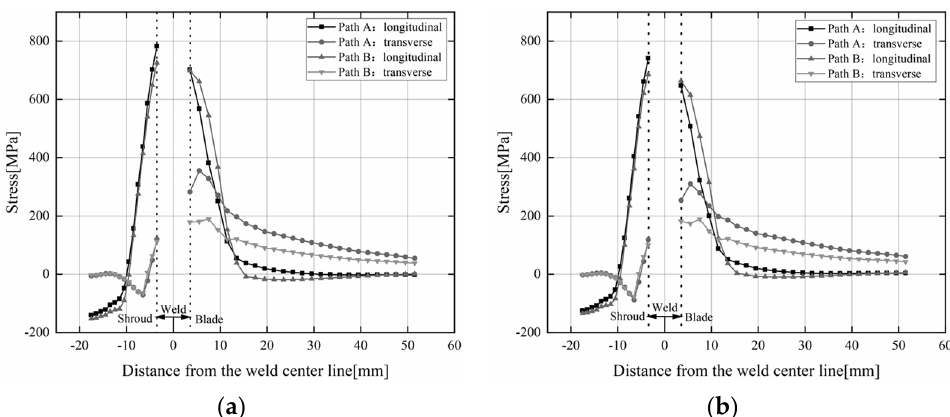
Figure 14. Transverse and longitudinal residual stresses along Path 1, Path 2. ( a ) Preheat—50 °C; ( b ) Preheat—150 ◦ ( b ) Preheat—150 °C.